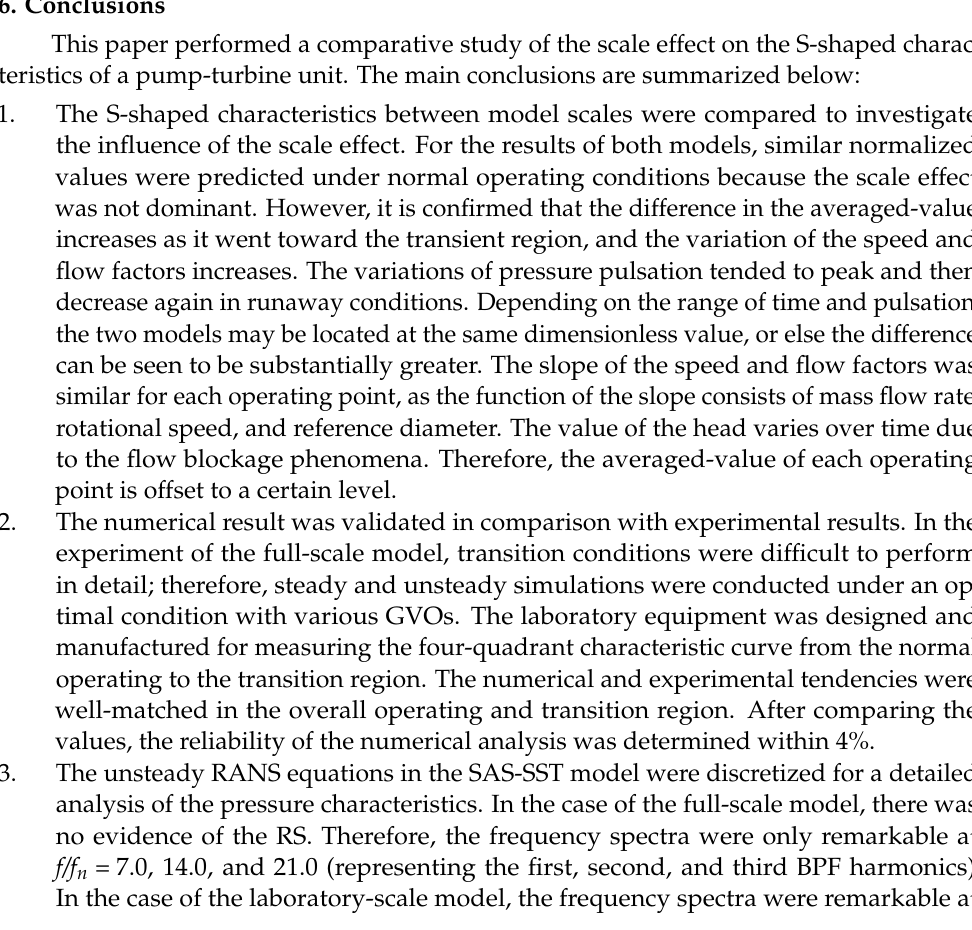
Figure 21. Efficiency change in hydraulically similar operating conditions having different Reynolds values (A and B).